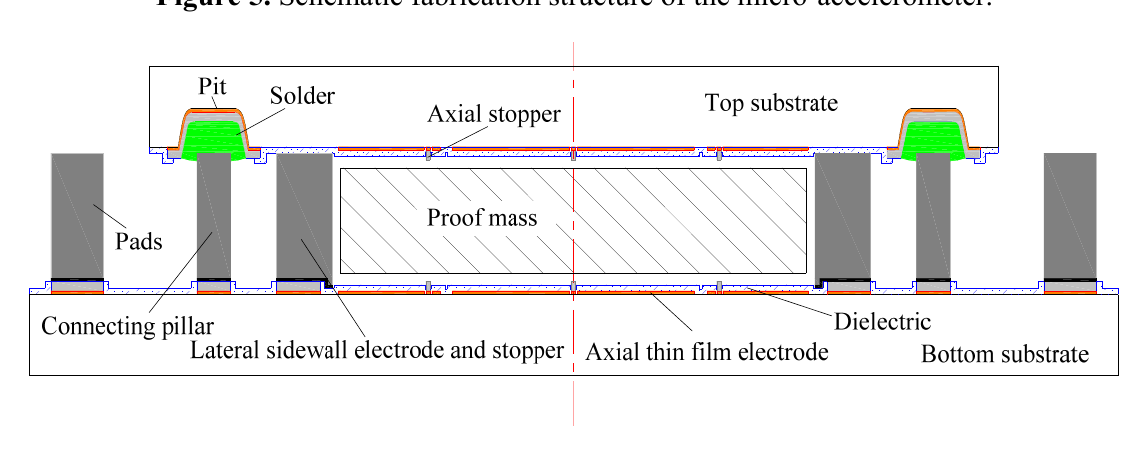
Figure 5. Schematic fabrication structure of the micro-accelerometer.